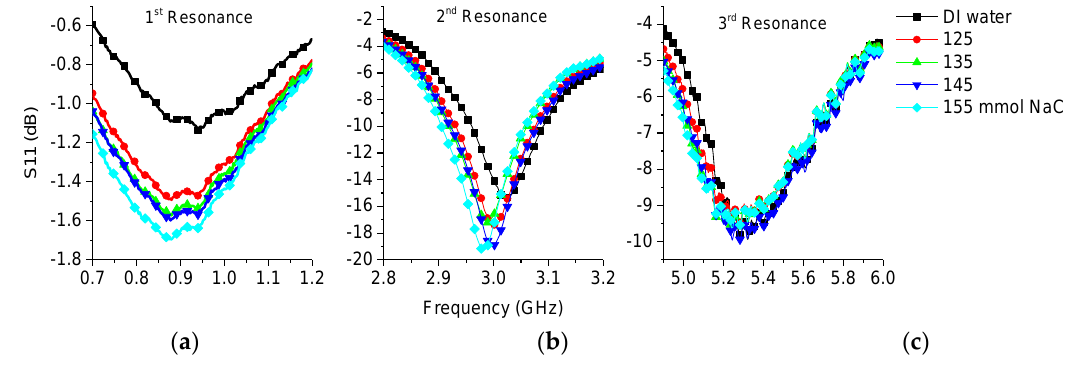
Figure 13. Measurement results of saline water with different concentrations: ( a ) 1st resonance; ( b ) 2nd resonance; ( c ) 3rd resonance.